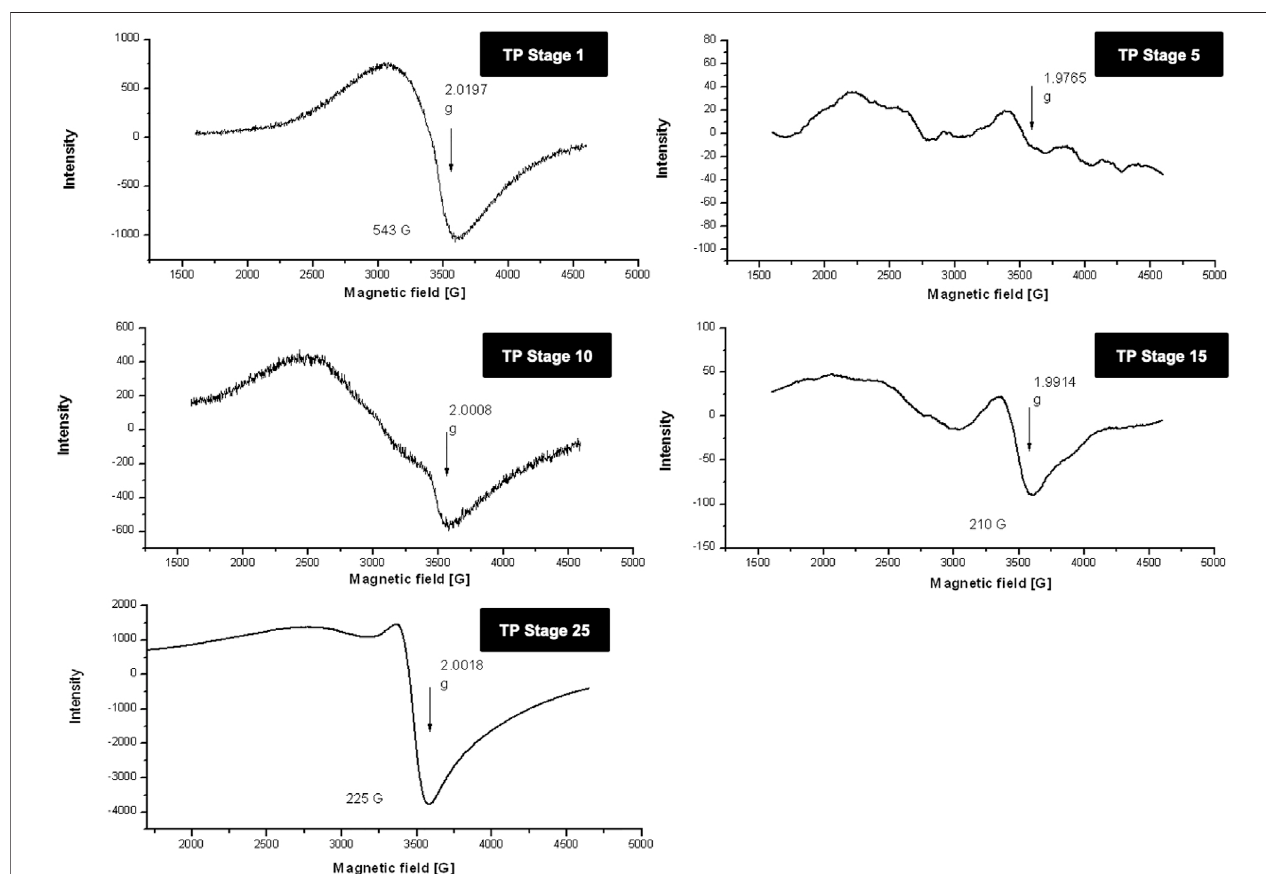
FIGURE3| Roomtemperatureelectronparamagneticresonance(EPR)spectraofvariousstagesofThamiraparpampreparedbythetraditionalancientmethodin comparison to the laboratory method of TP preparation. (A) Stage-1 TP; (B) Stage-5 (C) Stage-10 TP (D) Stage-15 TP; (E) Stage-25 TP.